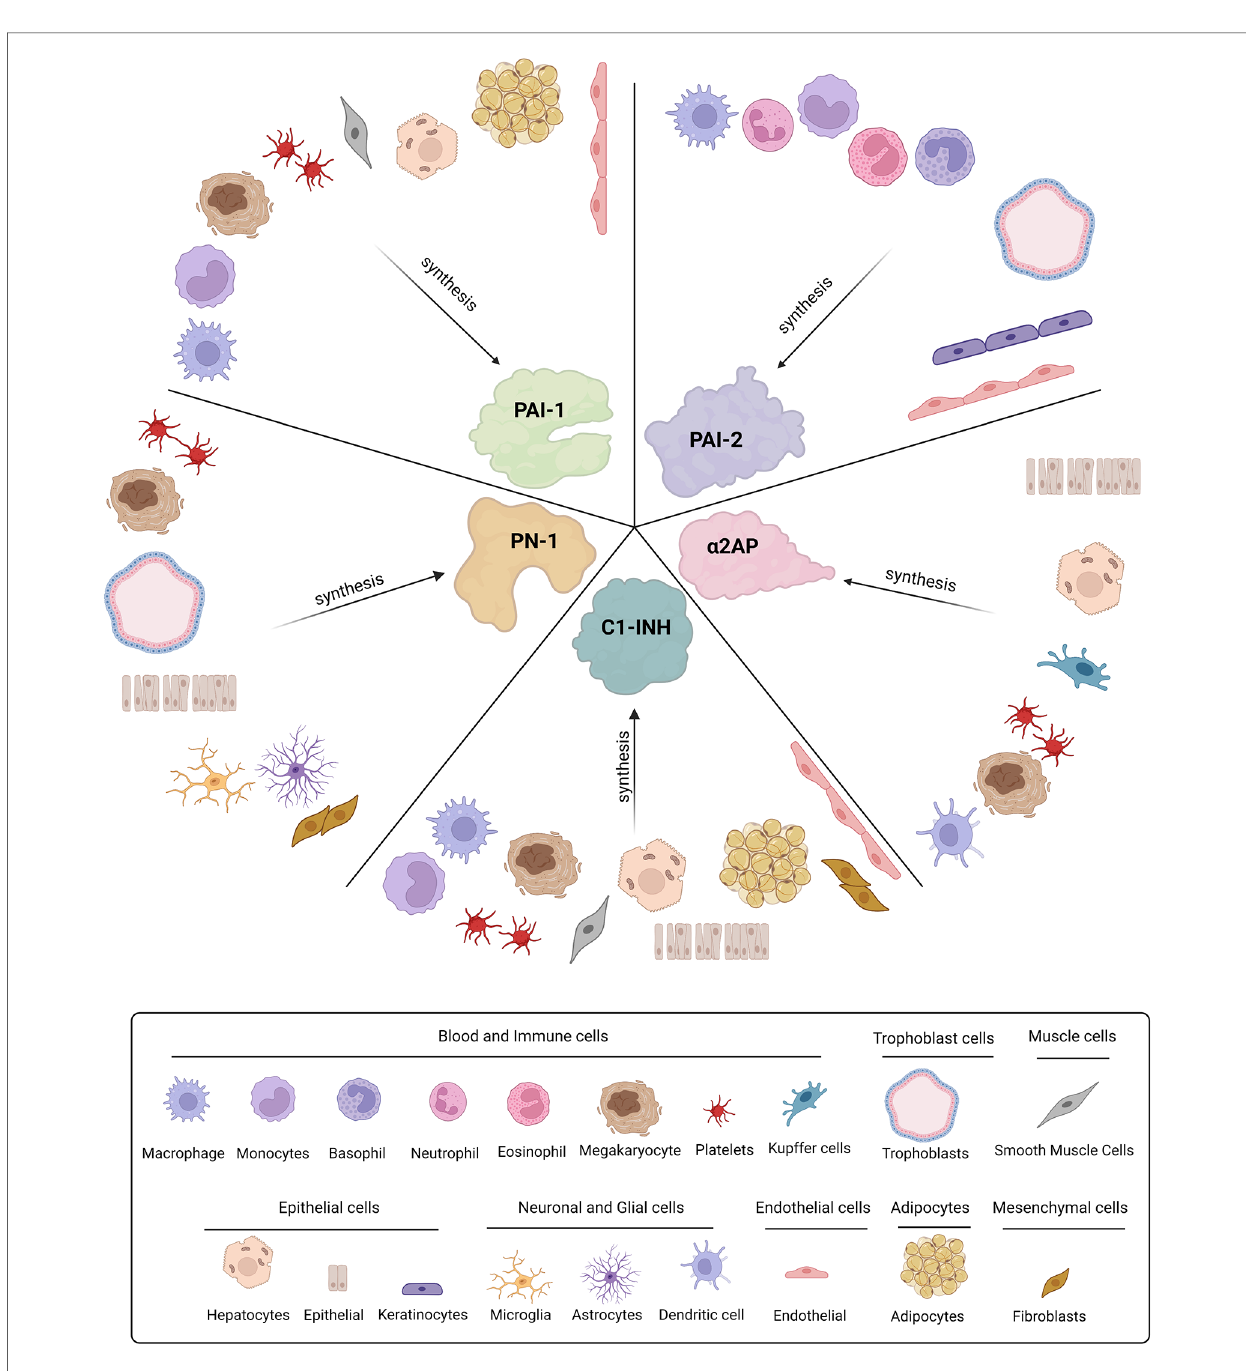
FIGURE 2 Cellular origins of SERPINs involved in fi brinolysis. Plasminogen activator-1 and -2 (PAI-1 and PAI-2), Protease nexin-1 (PN-1), alpha2-antiplasmin ( α 2AP), and C1-inhibitor (C1-INH) are all synthesised by various cell types throughout the